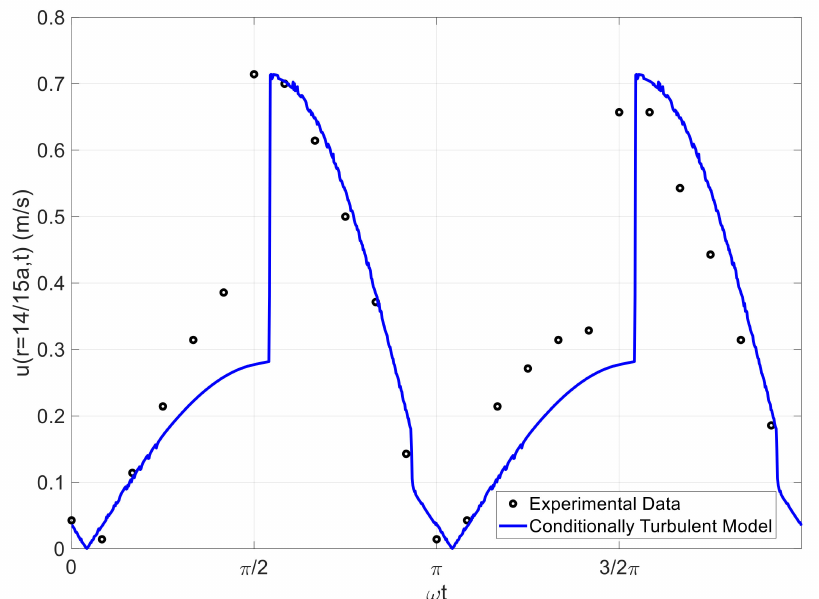
Figure 7. Comparison between the conditionally turbulent model and the experimental data for phase-averaged velocity near the wall ( r / a = 14/15) for Case 1: Re os = 5830, α =